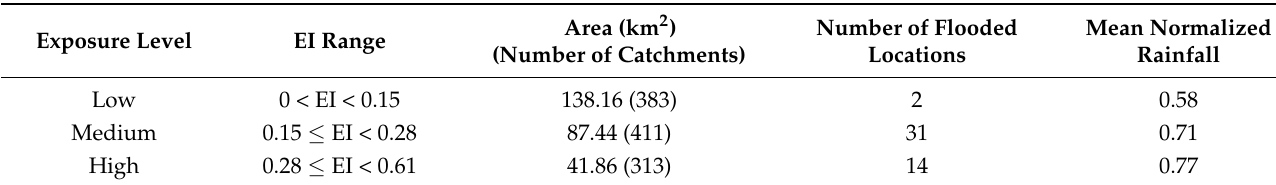
Figure 4. Exposure index. Table 2. Summary of exposure index (EI) of flooded locations based on EI level.